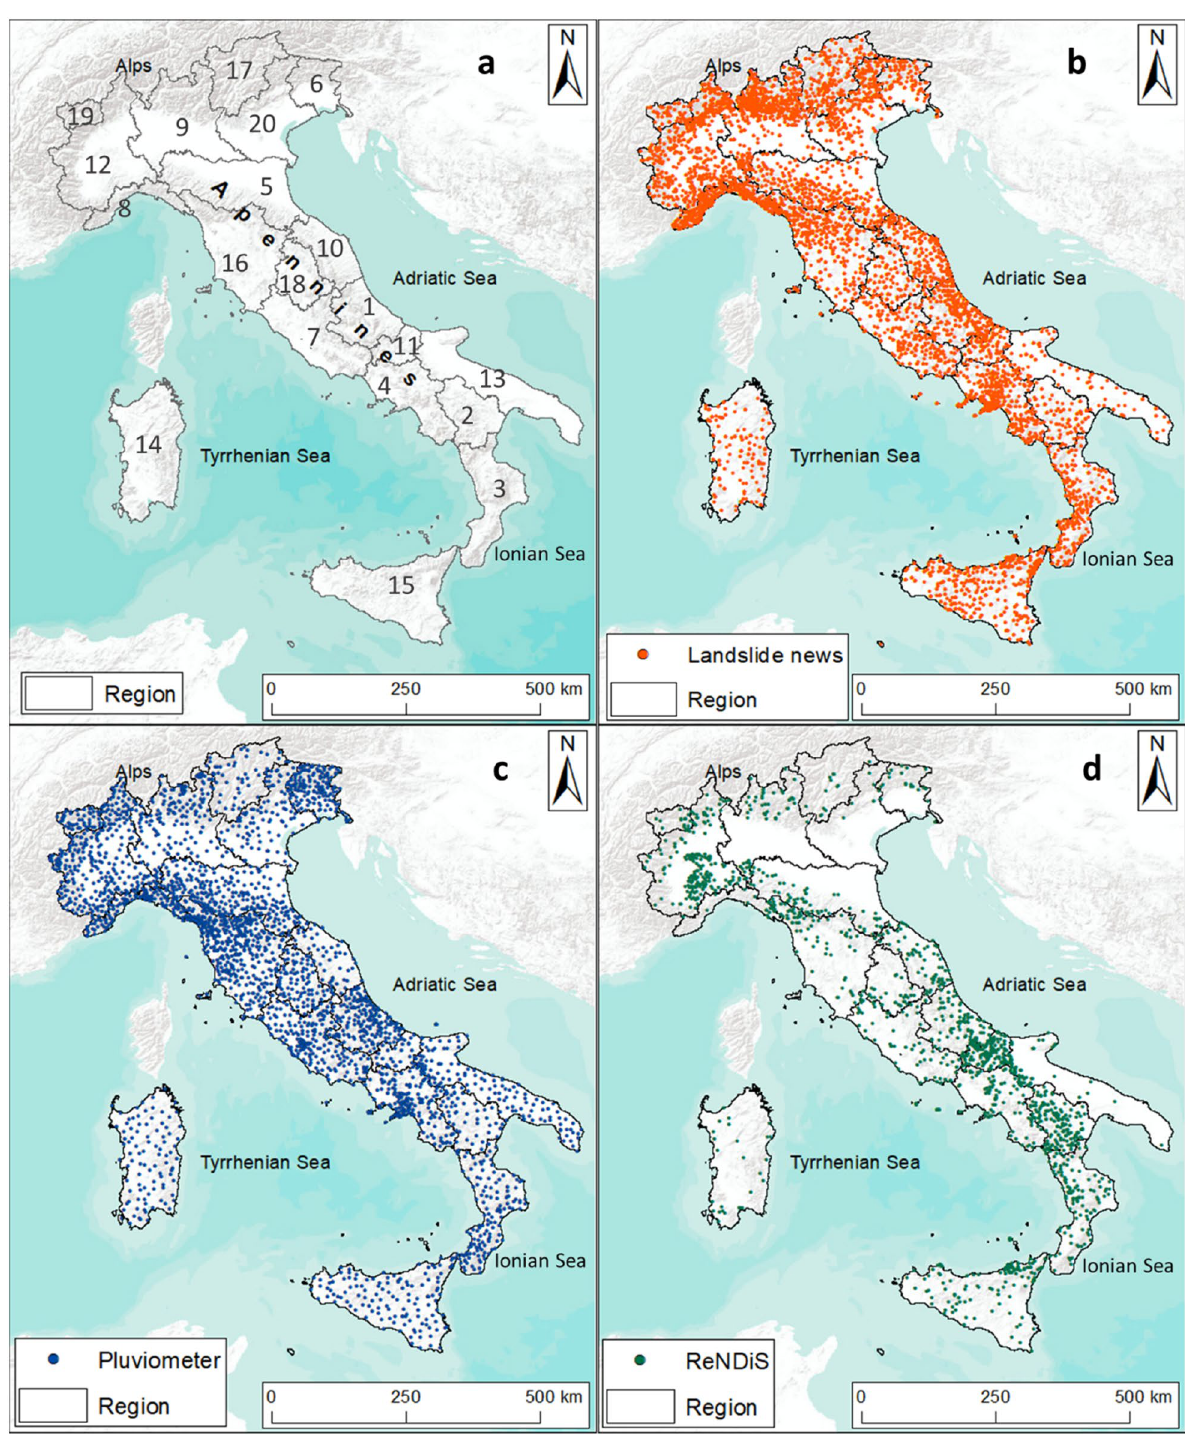
Figure 1. ( a ) Italian regions, 1: Abruzzo, 2: Basilicata, 3: Calabria, 4: Campania, 5: Emilia Romagna, 6: Friuli Venezia Giulia, 7: Lazio, 8: Liguria, 9: Lombardy, 10: Marche, 11: Molise, 12: Piedmont, 13: Puglia, 14: Sardinia, 15: Sicily, 16: Tuscany, 17: Trentino Alto Adige, 18: Umbria, 19: Valle d’Aosta, 20: Veneto; ( b ) Distribution of “Landslide news”; ( c ) Rain gauges across the Italian territory; ( d ) ReNDiS data for landslide events. The map was generated using ESRI ArcMap 10.8.1 (https:// www. arcgis. com/ home/ item. html? id= 33064 a20de 0c48d 2bb61 efa8f aca93